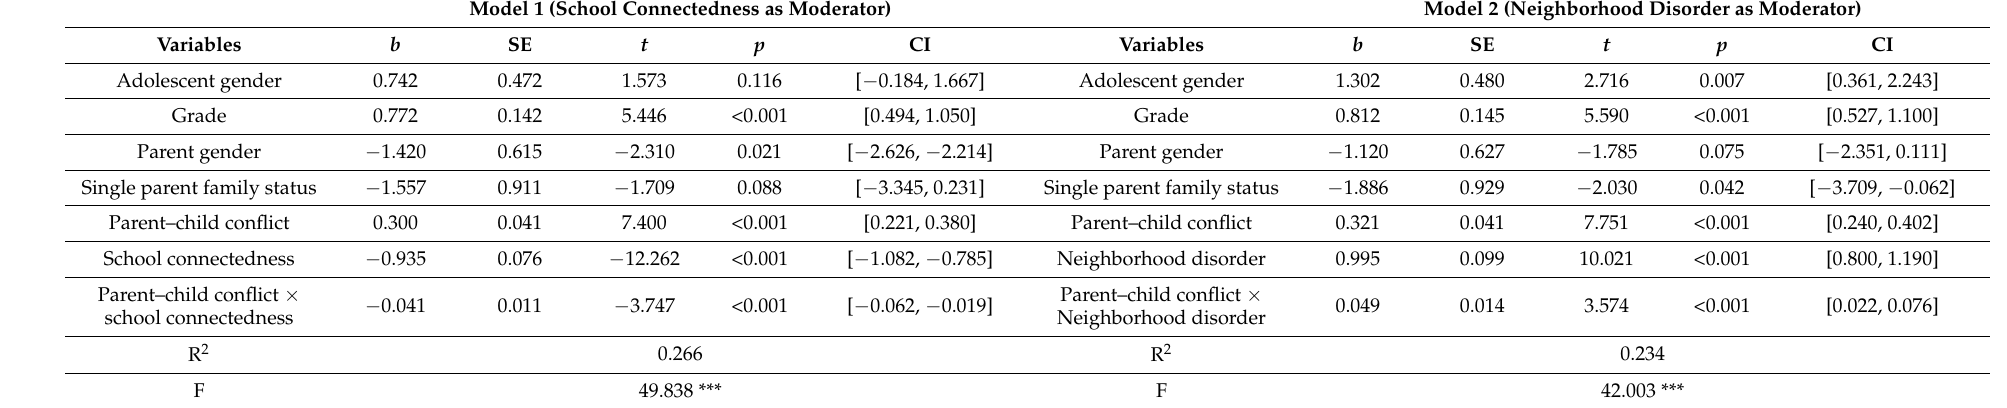
Table 2. Results of moderation analysis with bootstrapping